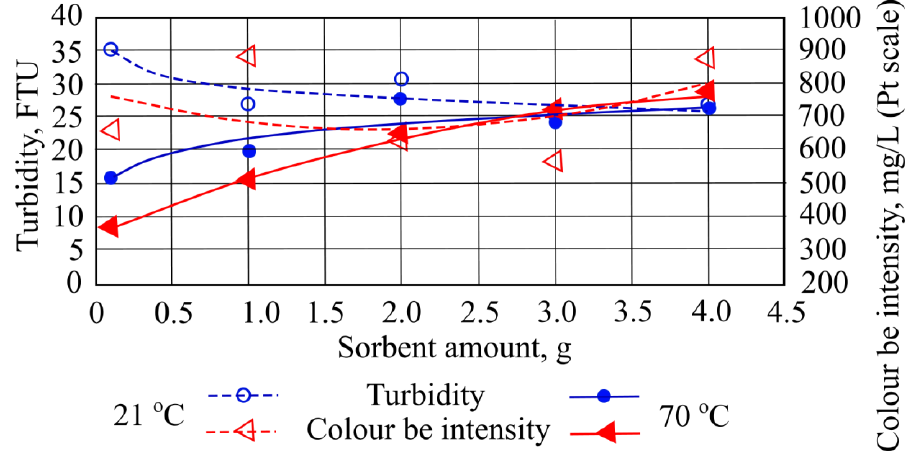
Figure 6. Turbidity and color be intensity values when different quantities of hydrophobic peat sorbent are added to the wastewater.